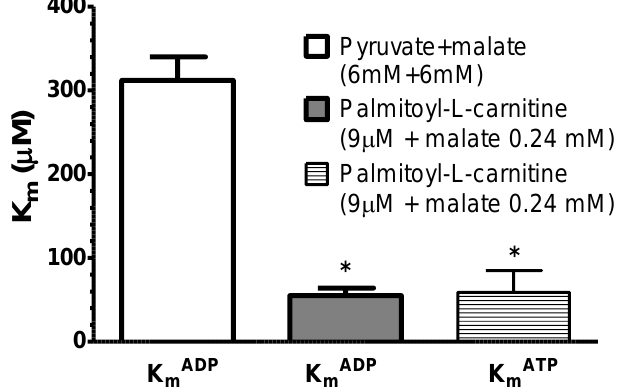
Figure 8. Influence of the adenosine diphosphate (ADP) source (endogenous (from exogenous adenosine triphosphate (ATP)) or exogenous) on the apparent K mADP of saponin-permeabilized rat cardiac fibers oxidizing palmitoyl- L -carnitine (9 μM) in the presence of malate (0.24 mM) or pyruvate + malate (control, 6 mM + 6 mM). Experiments were performed at 37 °C. * p < 0.05 vs. control. n = 5 (paired experiments). The results were analyzed with one-way analysis of variance (ANOVA) followed by Dunnett post hoc test.